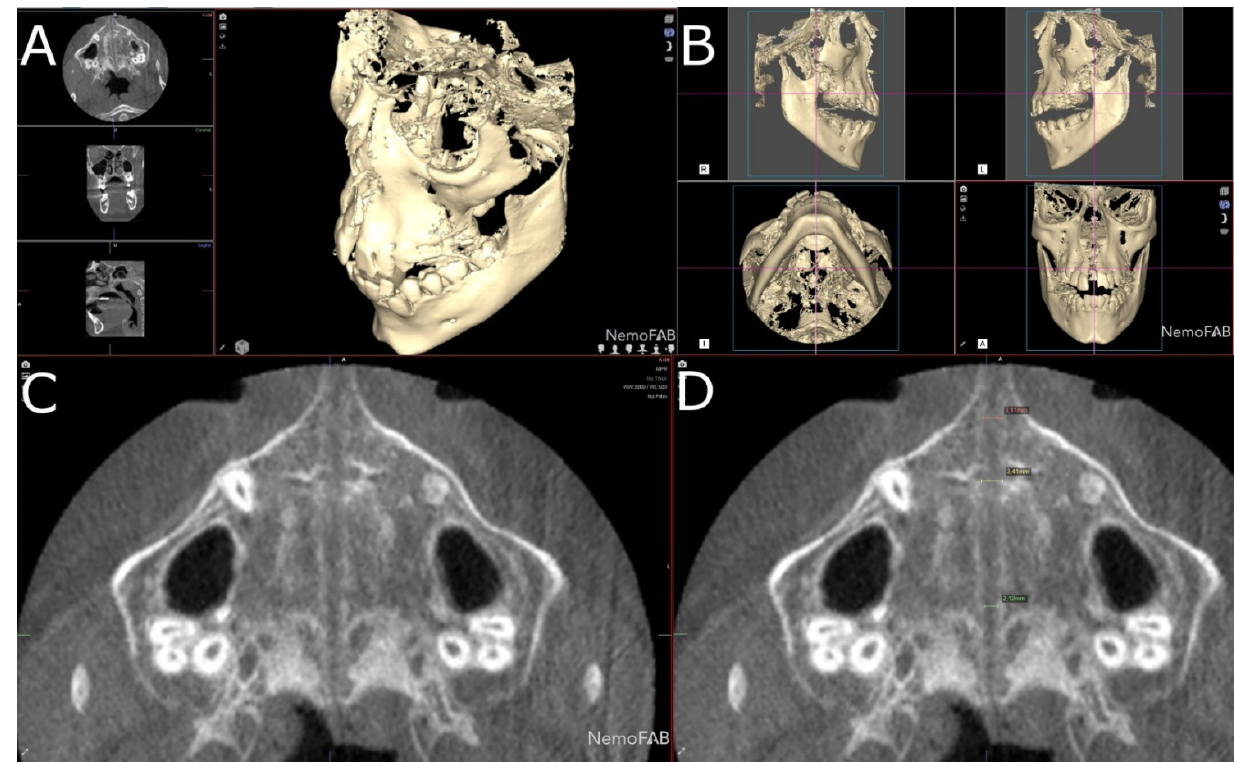
Figure 5. ( A ) CBCT scan uploaded to the three-dimensional orthodontic-planning software, ( B ) alignment procedure of the CBCT scan, ( C ) alignment and ( D ) measurement procedure of the palatine suture expansion at the central incisors, canines and first permanent molars.